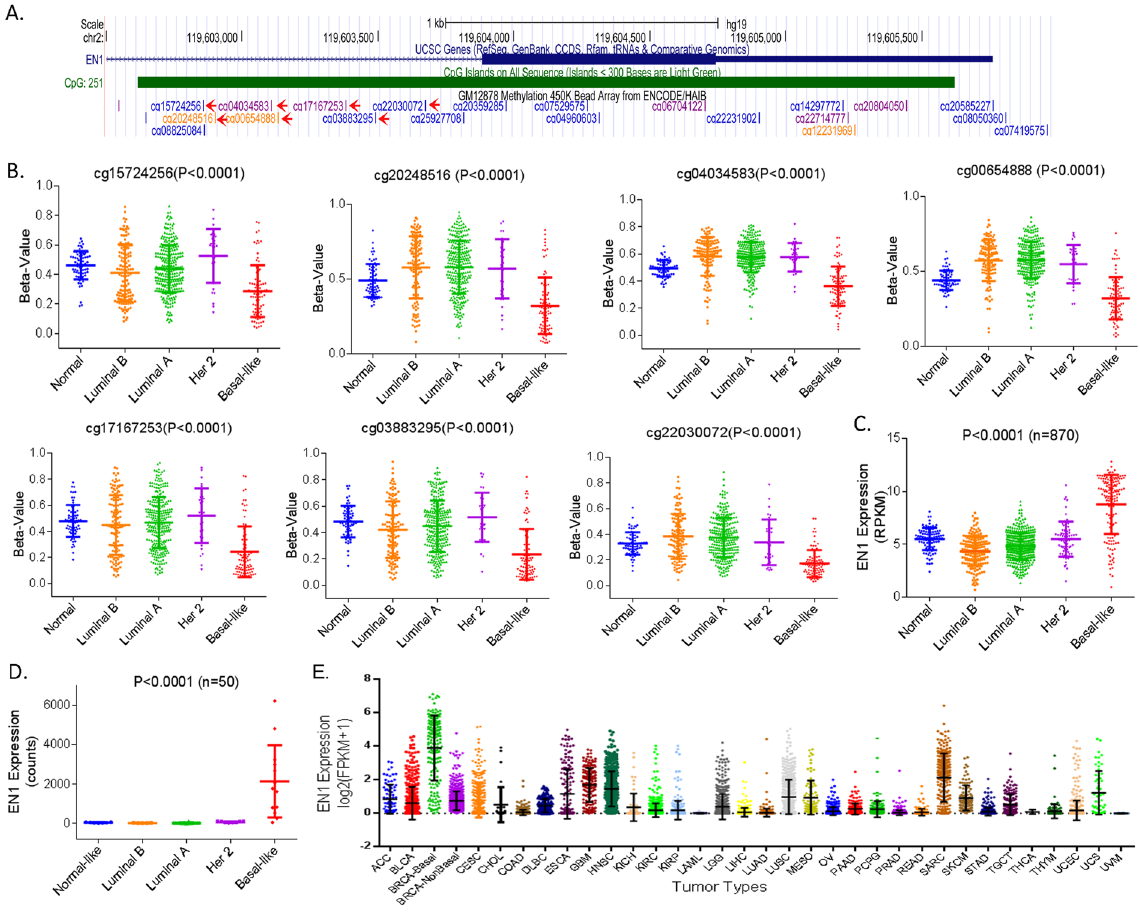
Figure 5. Hypomethylation of the EN1 Promoter and Increased EN1 Expression in Basal-like Breast Tumors. ( A ) Arrows indicate seven CpG sites of the EN1 promoter analyzed. ( B ) Analysis of TCGA HumanMethylation450 Array data showed significantly lower methylation in seven CpG sites of the EN1 promoter in BLBC tumors compared to normal breast tissues and other subtype breast tumors (p < 0.001). Beta values (0 to 1) are relative values increasing from hypomethylation to hypermethylation. ( C , D ) EN1 expression is significantly higher in basal like tumors compared to other subtype tumors, both in TCGA ( C ) and our RNA- seq datasets ( D). ( E ) EN1 expression was analyzed using Pan-Cancer RNA-seq datasets and presented as log 2 (FPKM + 1) values. Abbreviations of tumor types are described in Fig. 2A